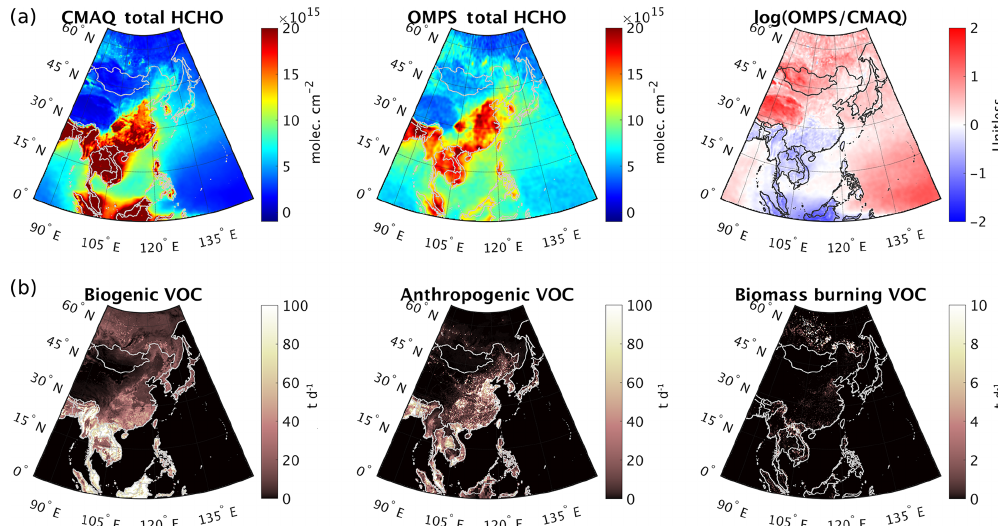
Figure 5. (a) HCHO total columns from the WRF-CMAQ model, OMPS (using adjusted AMFs based on the shape factors derived from the model and bias-corrected following the method proposed in Zhu et al., 2020), and the natural logarithmic ratio of OMPS / CMAQ during May–June 2016 at ∼ 13:30LST. (b) The major sources of VOC emissions in the area including biogenic emissions simulated by MEGAN, anthropogenic emissions estimated by MIX-Asia (2010), and biomass burning emissions made by FINN. The emissions are the daily mean values based on the emissions in May–June. The VOC emissions only add up those compounds that are included in the CB05 mechanism.